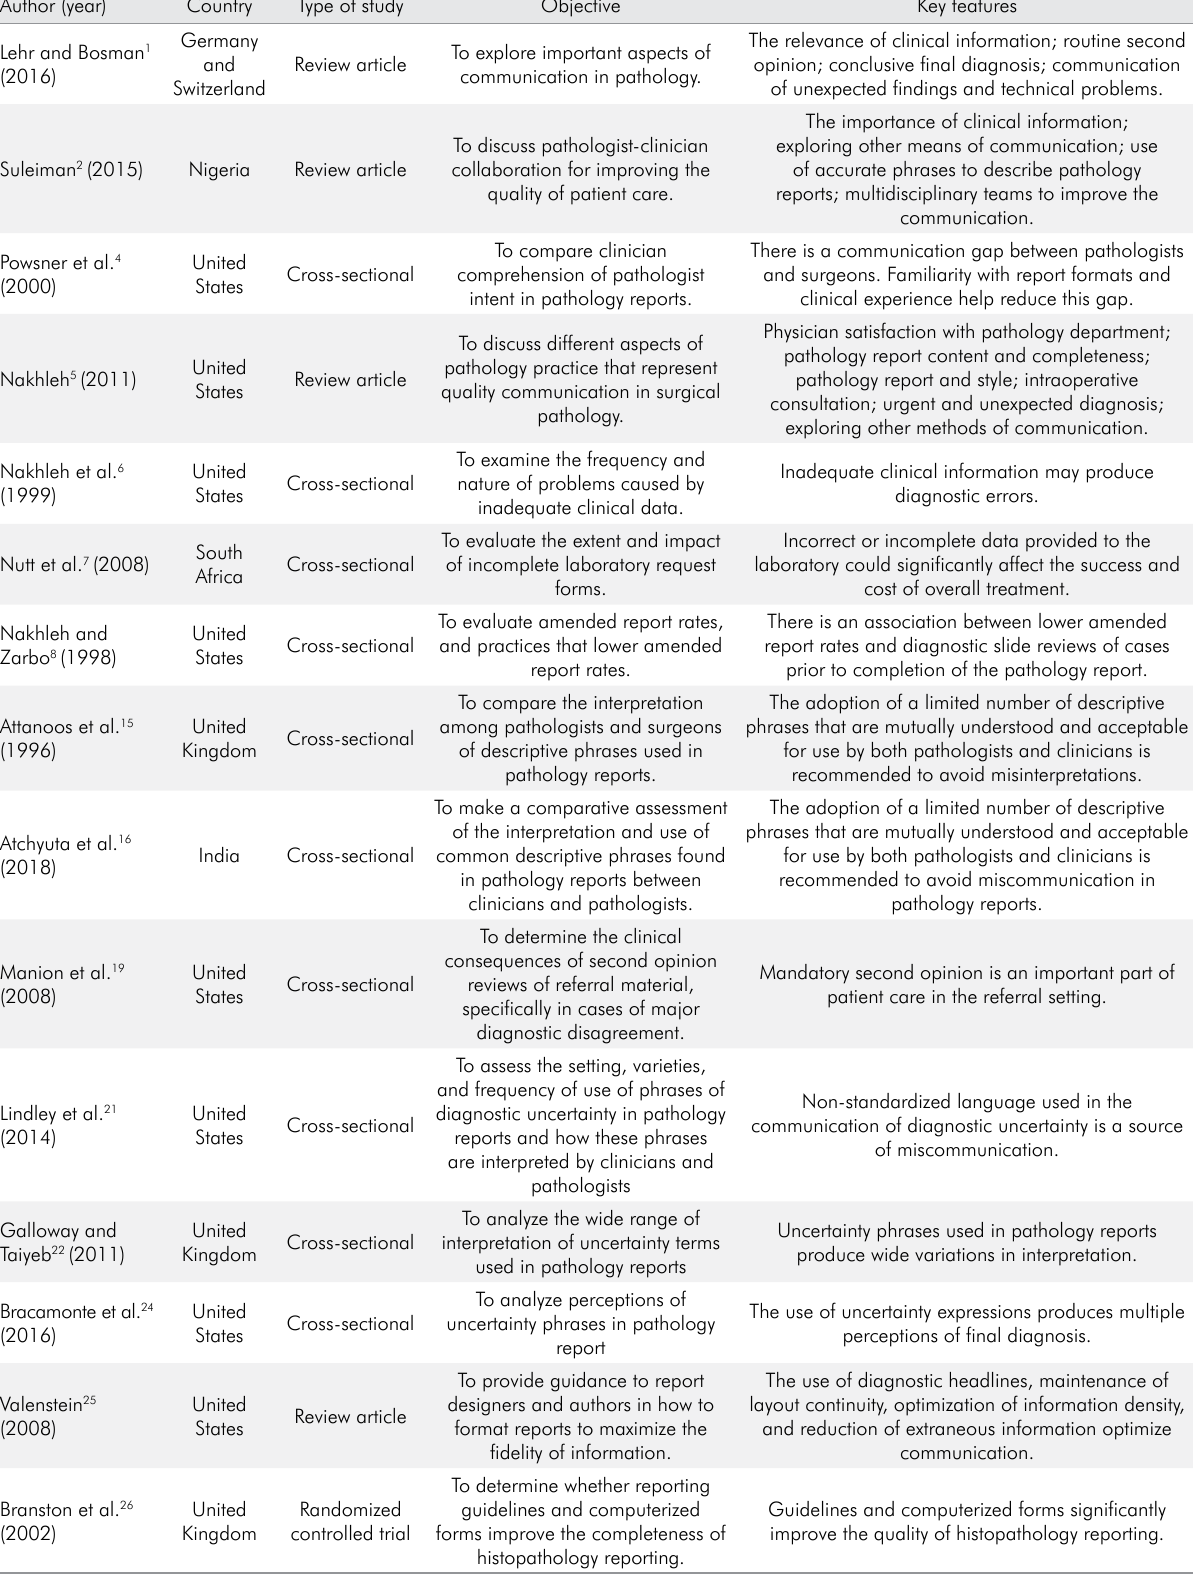
Table. Key features of studies concerning communication skills in the diagnostic